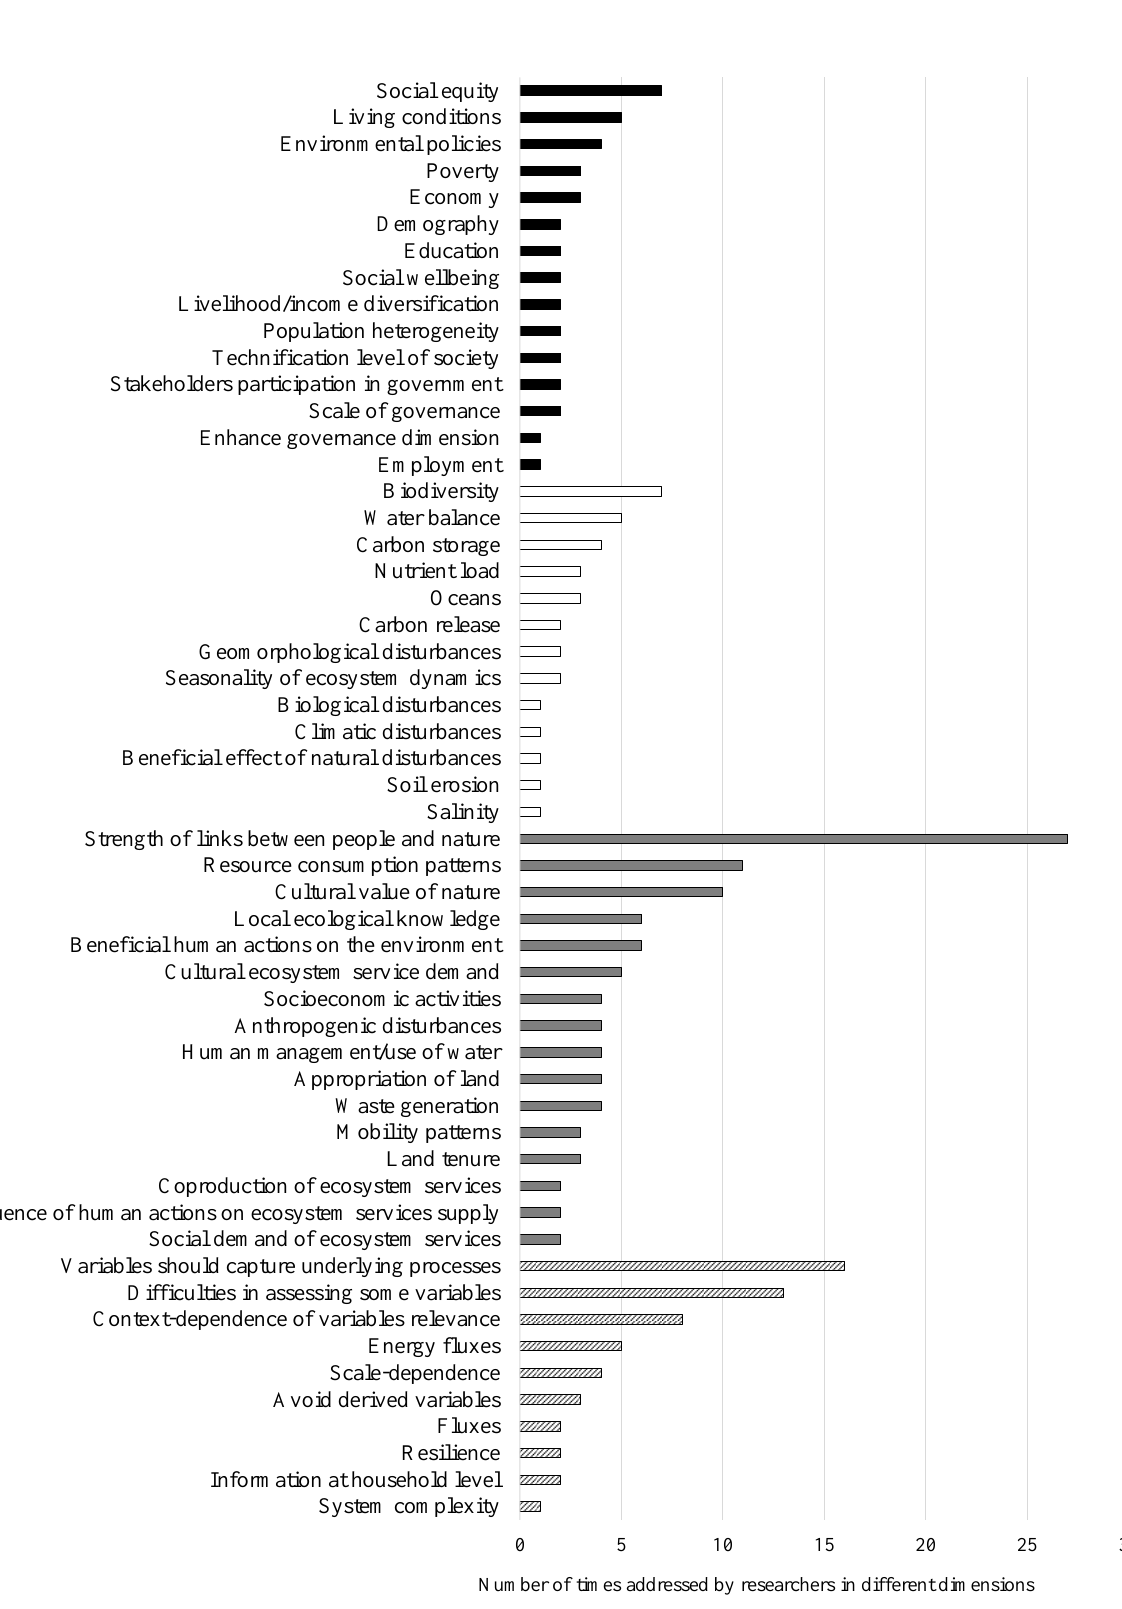
Figure A6.15. Extended version of Figure 4 in the manuscript. Featured topics addressed by respondents related to potential biases and gaps in the list of variables identified from comments and suggestions in the final survey. Black, white and gray bars represent the social system, ecological system and interaction components, respectively, while stripped bars reflect issues that are transversal to the whole conceptual framework. (See also these topics in the conceptual map of Appendix